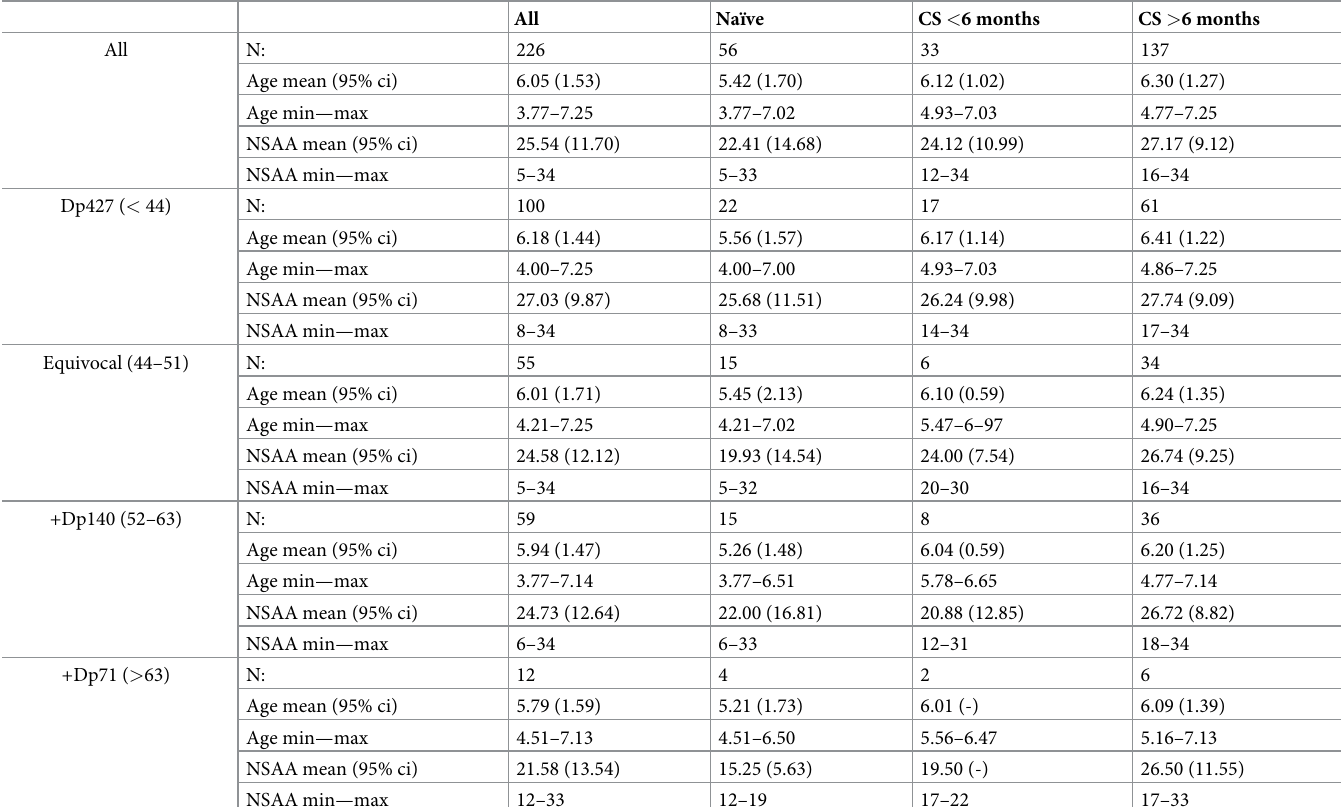
Table 2. Patient’s NSAA peak visit in the whole population and subgroups divided by brain dystrophin involvement and corticosteroids duration. All Na ï